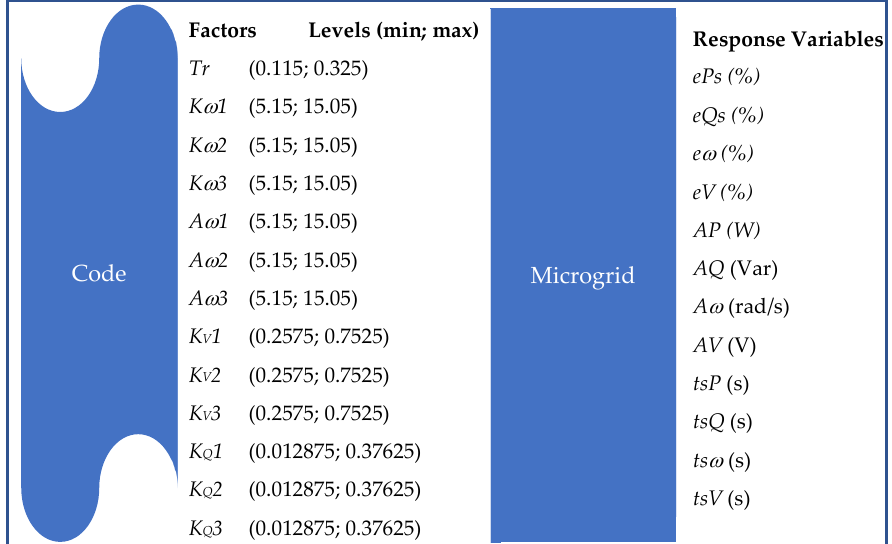
Figure 4. Process characterization of the system description.